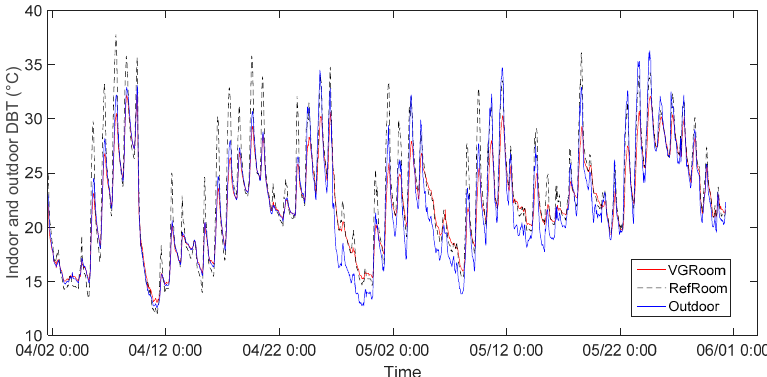
Figure 5. Indoor DBT values for the experimental rooms and the outdoor DBT. Table 3. Statistical results for the indoor DBT and RH.